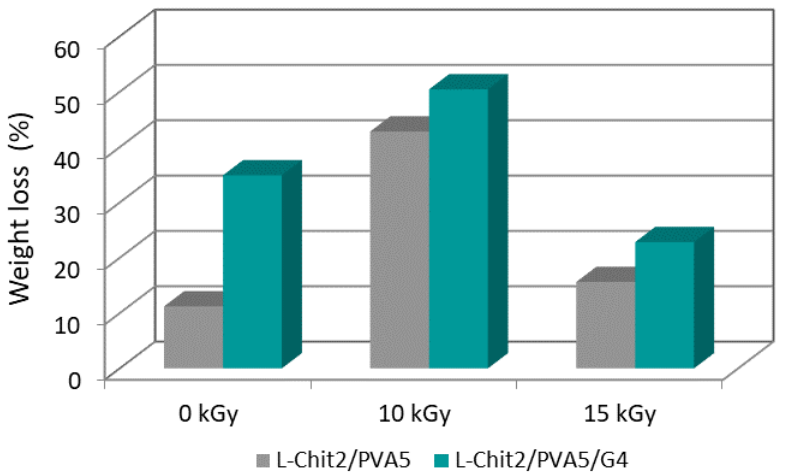
Figure 5. Weight loss of non-irradiated and  -irradiated low Mw chitosan-based membranes after 7 days immersed in saline solution at 36 °C (error minor than 1% in all